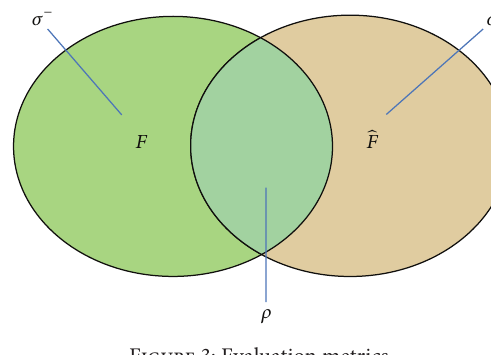
Figure 3: Evaluation metrics.